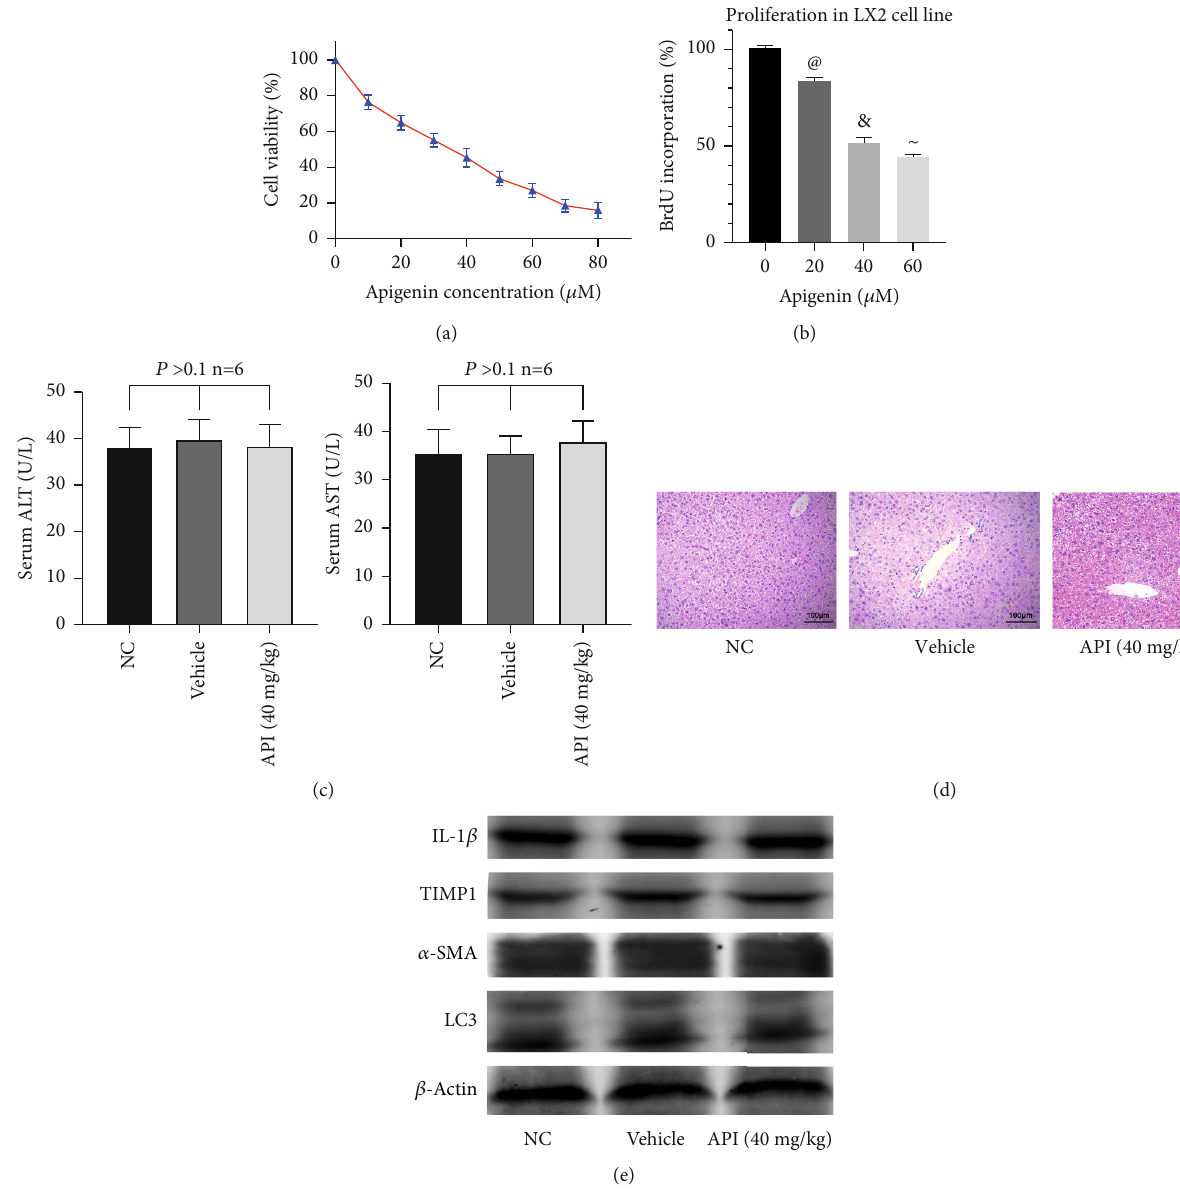
Figure 1: E ff ects of apigenin on liver and LX2 cells. Notes: (a) the CCK8 assay was used to determine the e ff ects of apigenin on the viability of LX2 cells. (b) Cells were treated with the indicated concentrations of apigenin for 24 hours, and the degree of apigenin to inhibit cell proliferation was measured using BrdU Cell Proliferation ELISA Kit ( @ P < 0 : 05 for 20 μ M apigenin vs. 0 μ M apigenin; & P < 0 : 05